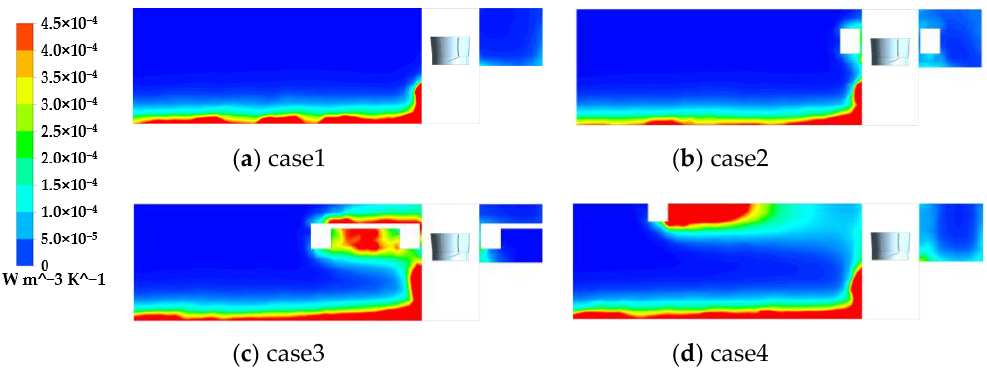
Figure 11. Contour of entropy production distribution in longitudinal section.